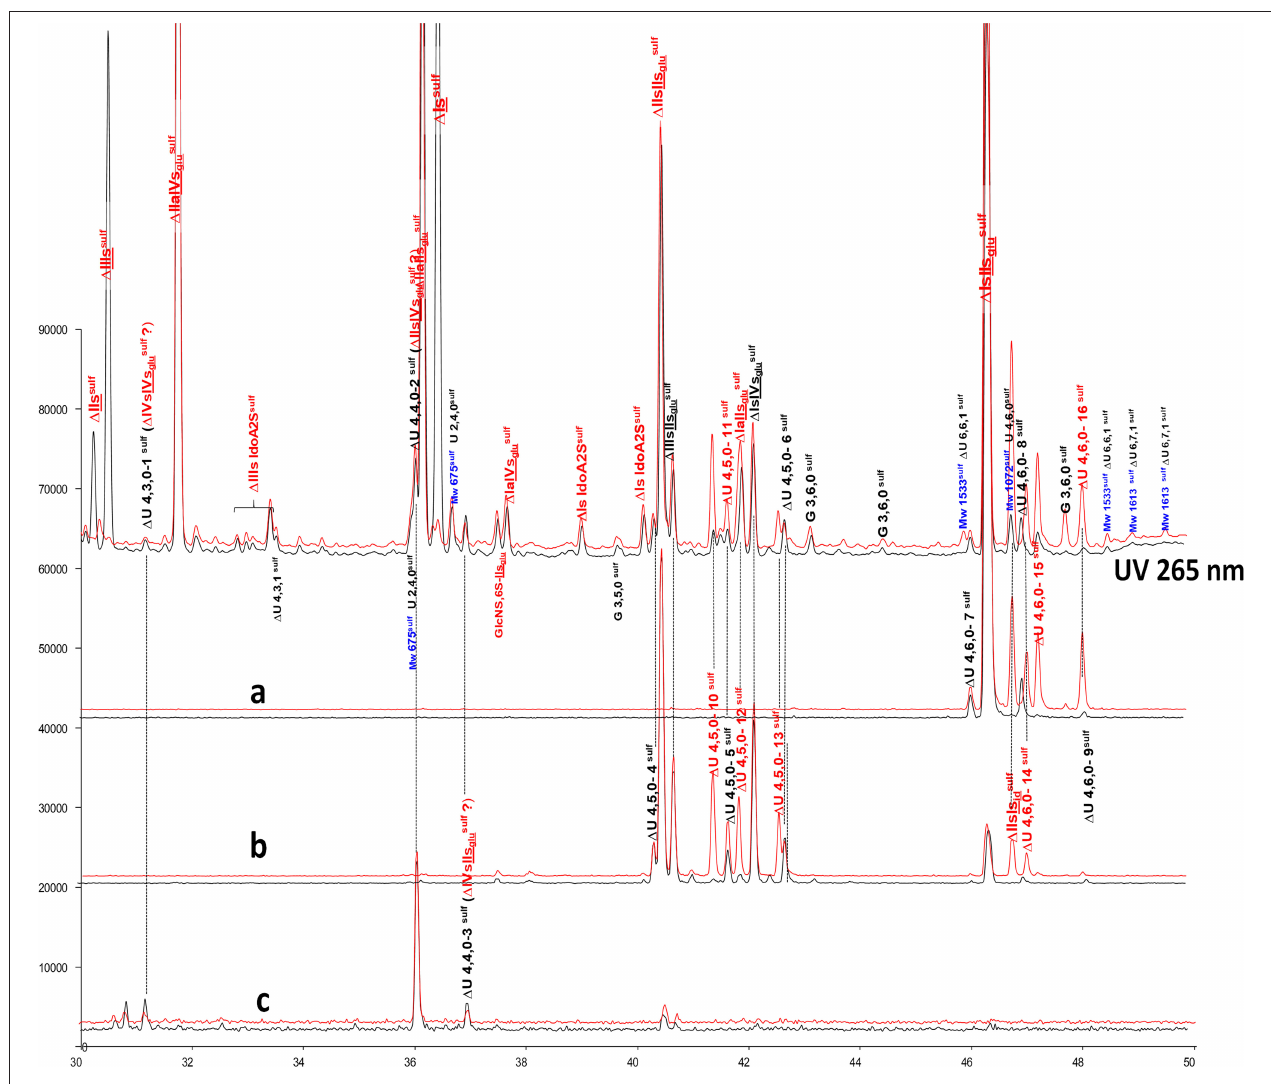
FIGURE 7 | Comparison by ion-pair liquid chromatography/mass spectrometry of heparinase I + II + III ( — ) and heparinase II ( — ) digests of bovine mucosal heparin high-affinity (HA1) fraction after sulfanilic reductive amination. (a) Reconstructed ion pair chromatograms (RIC) 1 U(4,6,0) sulf : m/z 712.2; (b) RIC 1 U(4,5,0) sulf : m/z 614.5 + 672.1; (c) RIC 1 U(4,4,0) sulf + 1 U(4,3,0) sulf : m/z